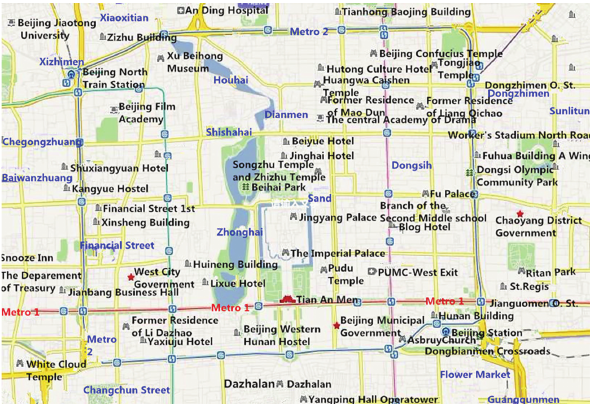
Figure 1: Beijing’s second ring